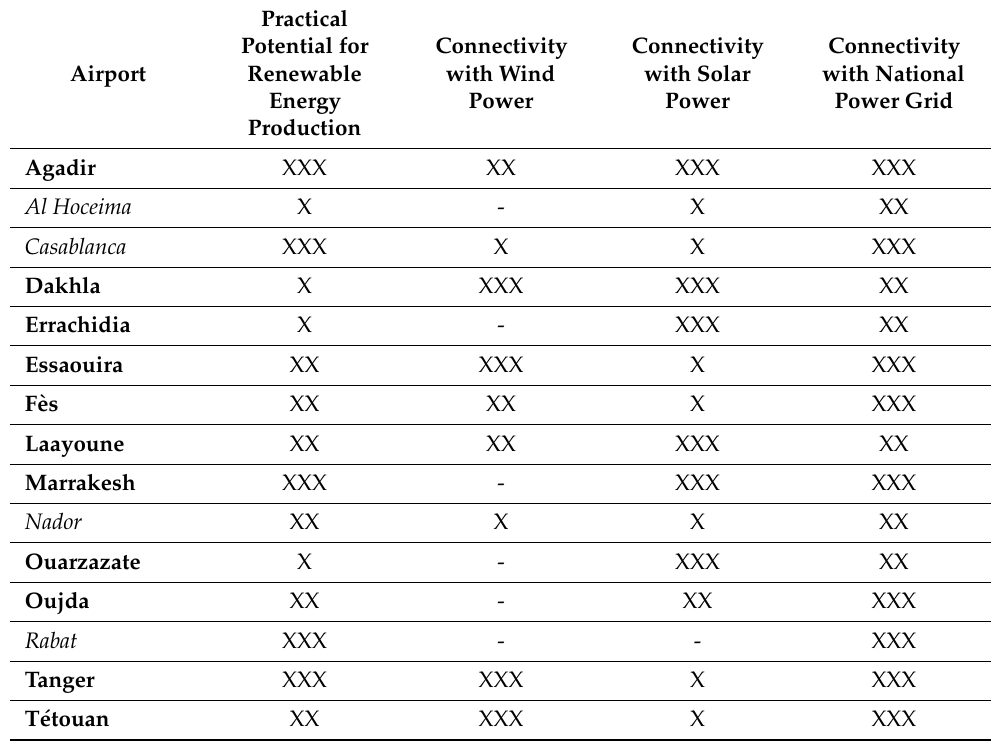
Table 2. Preliminary analysis of locations for renewable energy. Alternatives selected for further multicriteria analysis appear in bold. Practical Connectivity Connectivity Connectivity Potential for with with Wind Renewable Airport Power Power Energy Production